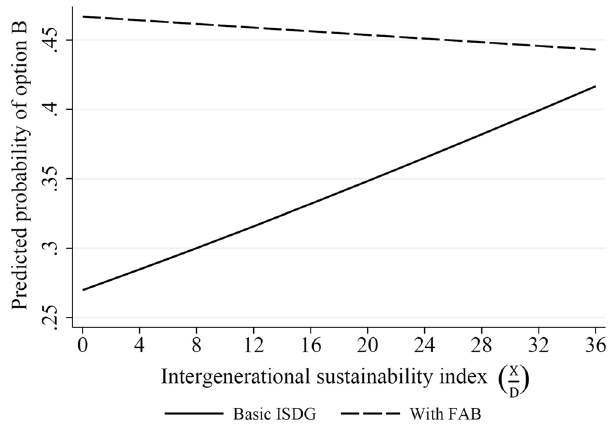
Figure 2. Predicted probabilities of choosing option B for subjects as a function of intergenerational sustainability index in the basic ISDG and FAB treatments.